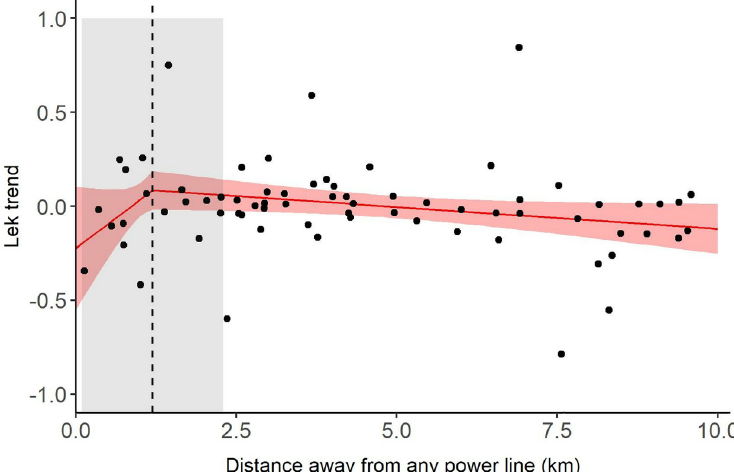
Fig 2. Effect of power lines on greater sage-grouse ( Centrocercus urophasianus ) lek trends and persistence in Utah, USA, 1998–2013. Lines represent the fitted values from the best-fit model of the effect of power lines on lek trends (S2 Appendix). The vertical dashed line identifies the response threshold at which sage-grouse response (i.e., lek trend) changed. Shaded areas highlight uncertainty (95% CI) around the location of the response